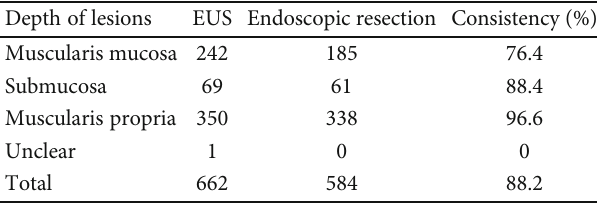
Table 3: EUS consistency in predicting the location of lesions. Depth of lesions EUS Endoscopic resection Consistency (%)